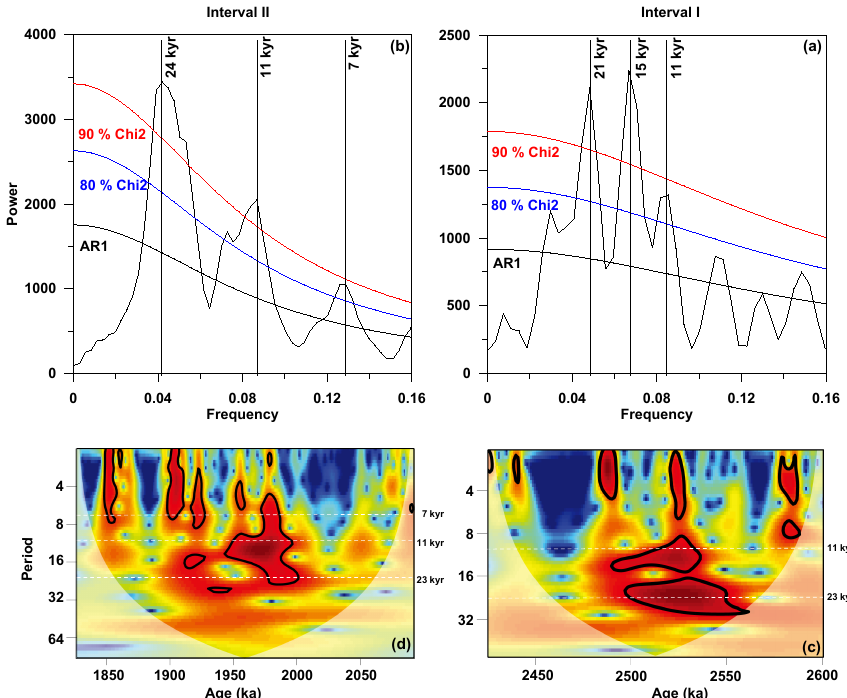
Figure 5. REDFIT power spectra of the grain-size values (63–150µm fraction in wt.%) for both investigated intervals of Site U1389: (a) Interval I: 2.6–2.4Ma; (b) Interval II: 2.1–1.8Ma. The 90% (red), 80% (blue) and AR1 red noise (black) confidence levels are given. (c) Wavelet analysis of the grain-size values (63–150µm fraction in wt.%) during Interval I and (d) wavelet analysis of the grain-size values (63–150µm fraction in wt.%) during Interval II. Cone of confidence (white) for both intervals is marked. Areas with >95% significance level are marked by black lines. Periods corresponding to (semi-, 1 / 3) precession are marked with dashed white